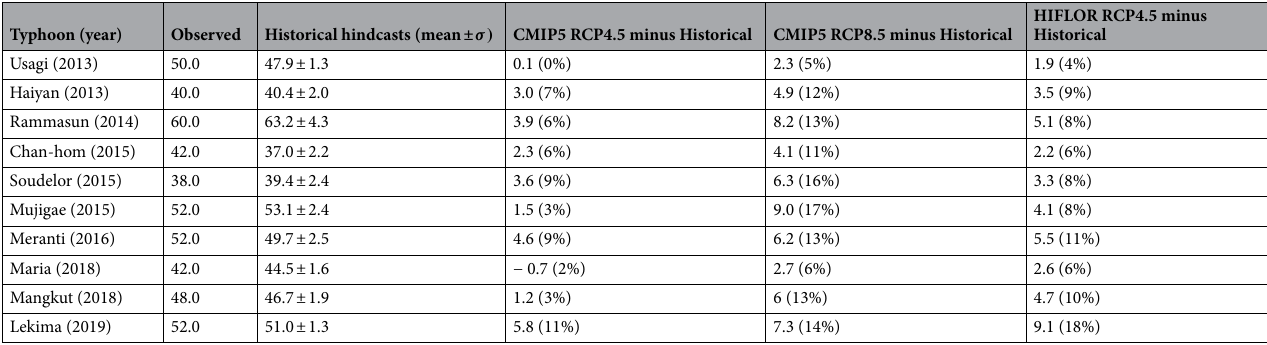
Table 1. Maximum 10-m wind speed at landfall (m/s). *The ensemble-mean difference in typhoon maximum 10-m wind speed (m/s) is given. Maximum wind speed is estimated by 10-member ensemble simulations. The change percentage of the ensemble-mean wind speed compared to hindcasts under the historical conditions is given in